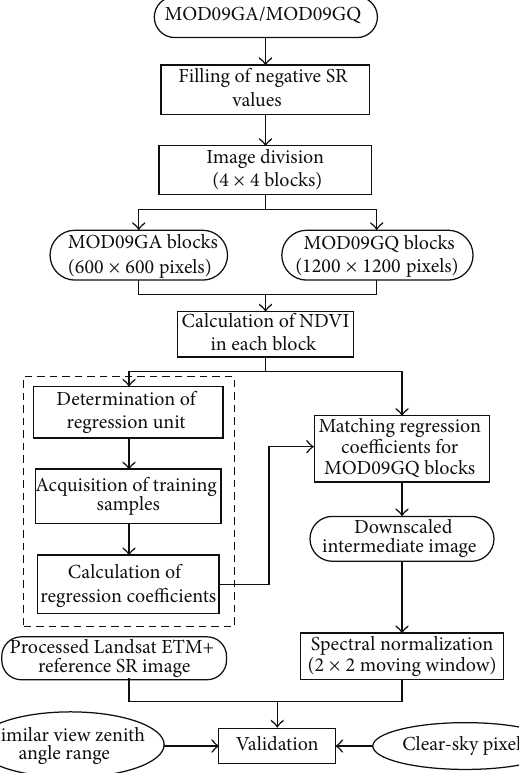
Figure 2: The flow chart for the downscaled